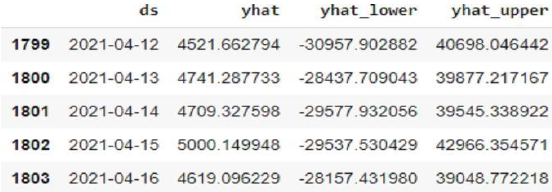
Fig 16. Prophet API prediction of Ether prices in the